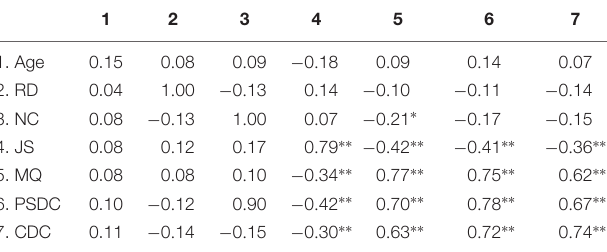
TABLE 2 | Correlations between study